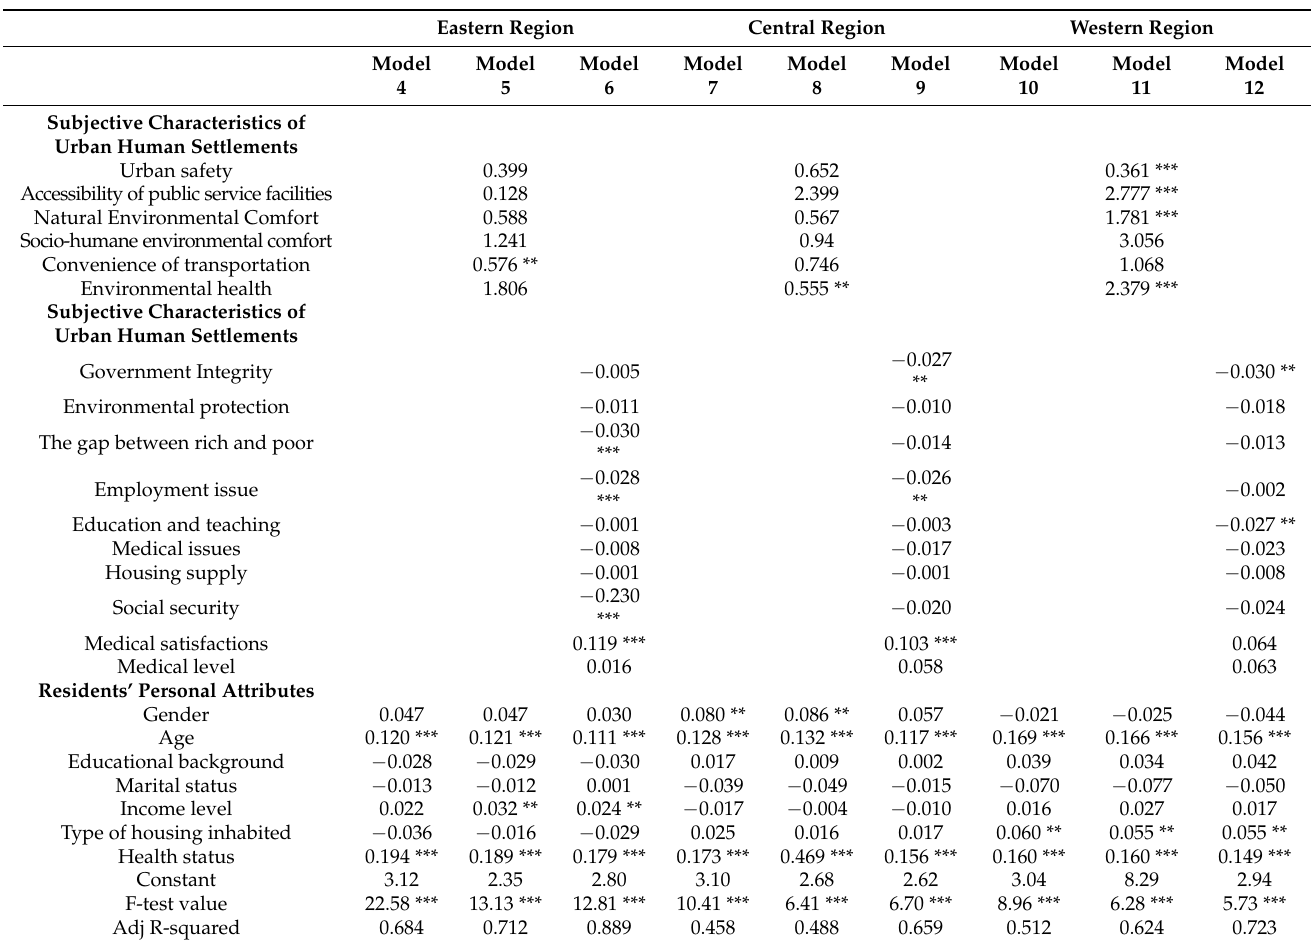
Table 5. Regional regression results of residents’ life